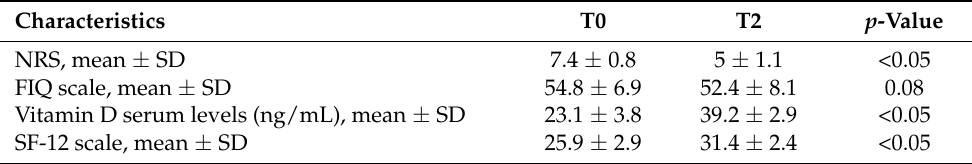
Table 5. Effects of vitamin D supplementation at 6 months in group B.